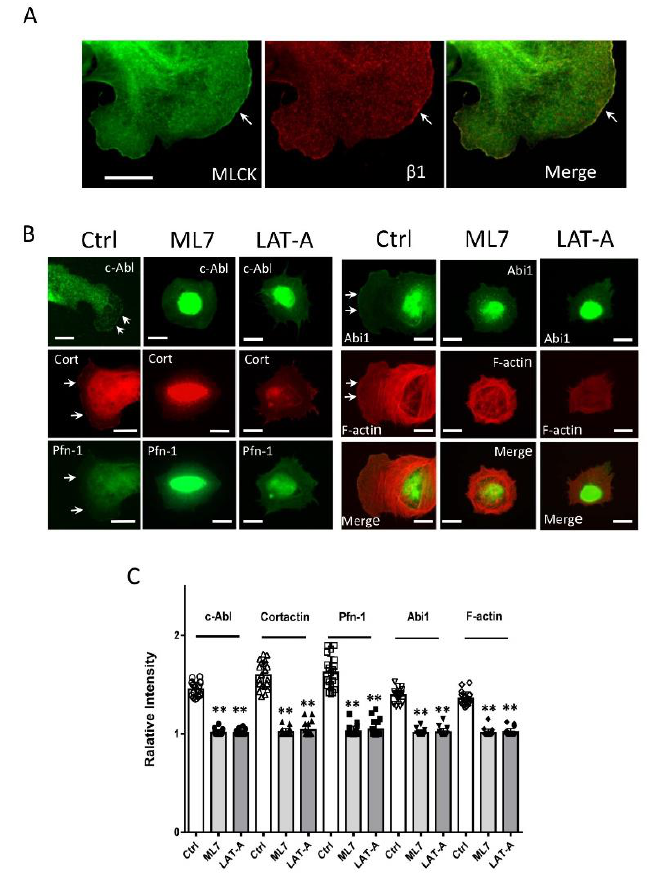
Figure 5. MLC 20 phosphorylation and actin polymerization regulate the recruitment of actin-regulatory proteins to the cell edge. ( A ) Myosin light chain kinase (MLCK) colocalizes with integrin β1 at the cell edge. Cells were immunostained for MLCK and integrin β1. The arrows point to the leading edge. Scale bar: 10 µm. ( B ) Cells were plated onto collagen-coated coverslips in the absence or presence of 1 µM ML7 or 10 nM latrunculin A (LAT-A) for 30 min. They were then stained for the indicated proteins or F-actin. Scale bar, 10 µm. Ctrl, control cells. The arrows point to the leading edges. ( C ) Data are mean values of experiments from at least 20 cells for each group. Error bars indicate SD. ** p < 0.01. One-way ANOVA was used for statistical analysis.